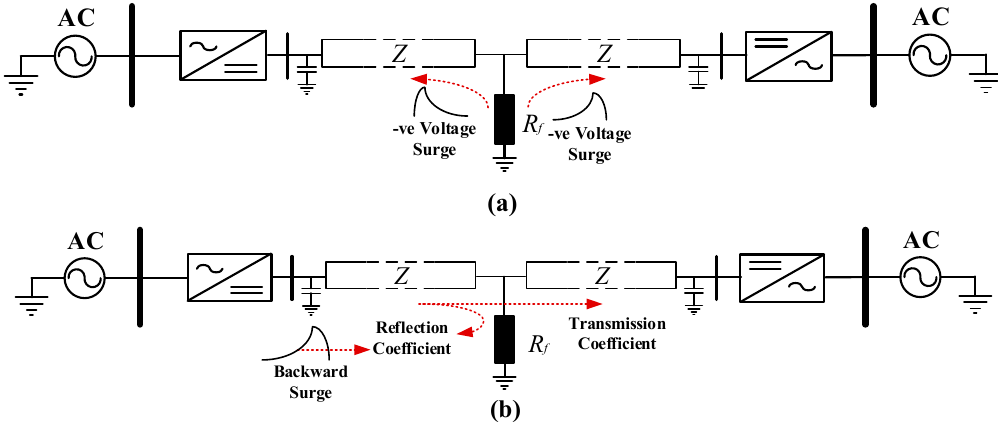
Figure 1. Reflection coefficient: ( a ) Right after the fault occurrence and negative voltage surge travels towards terminals, ( b ) Backward traveling surge, divides into transmission and reflection coefficient.